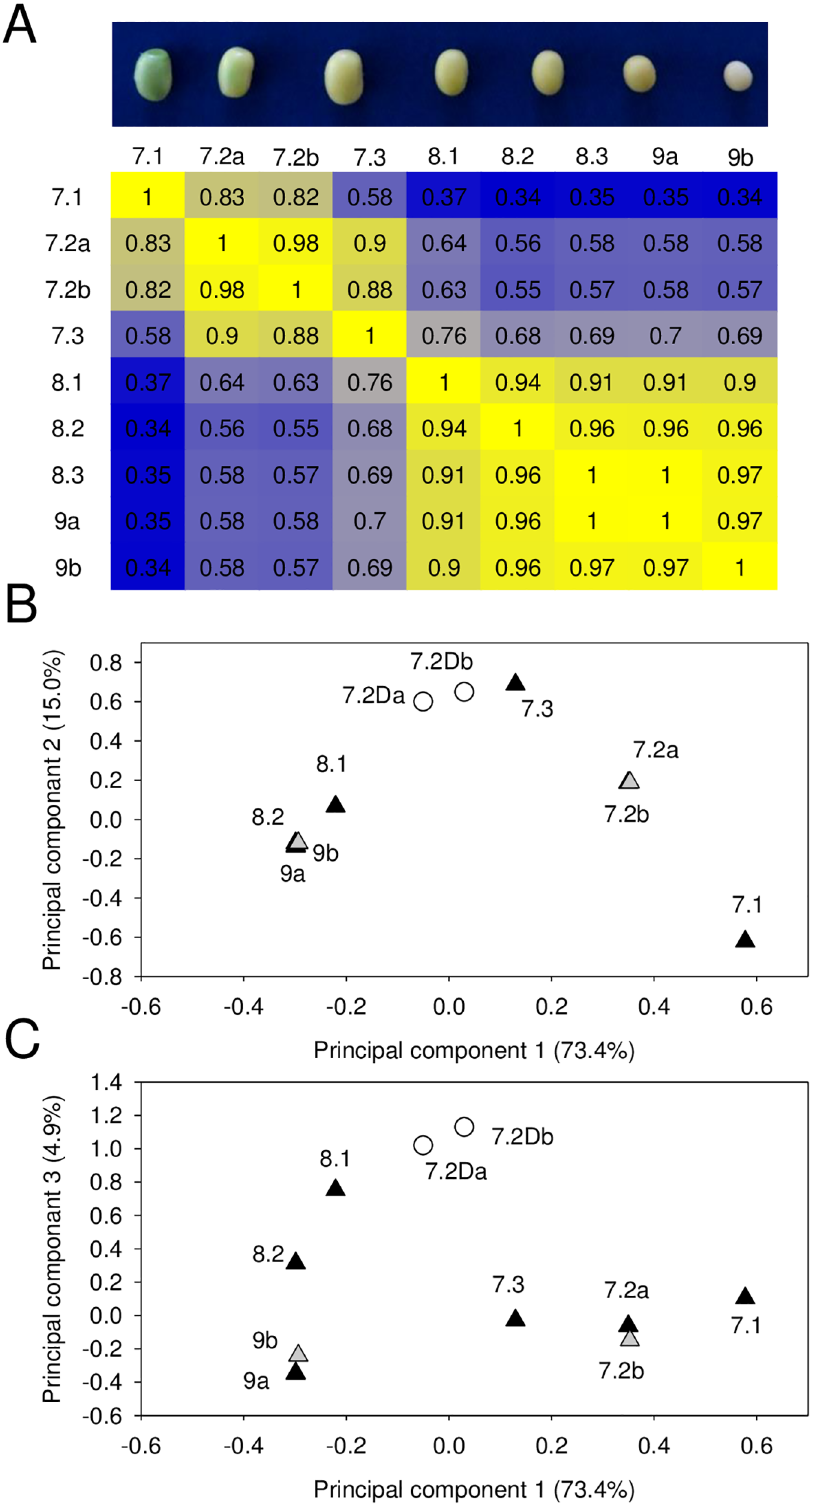
Fig 3. Correlation and principal component analysesof soybean transcriptomes during seed maturation. (A) Pair-wise Pearson correlationcoefficientswere used to generatethe heat map. The color